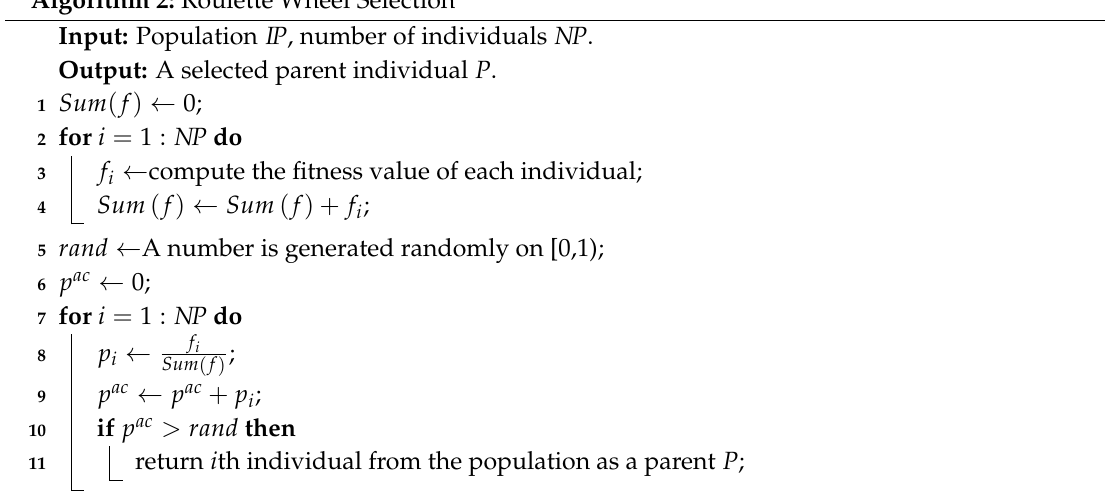
Algorithm 2: Roulette Wheel